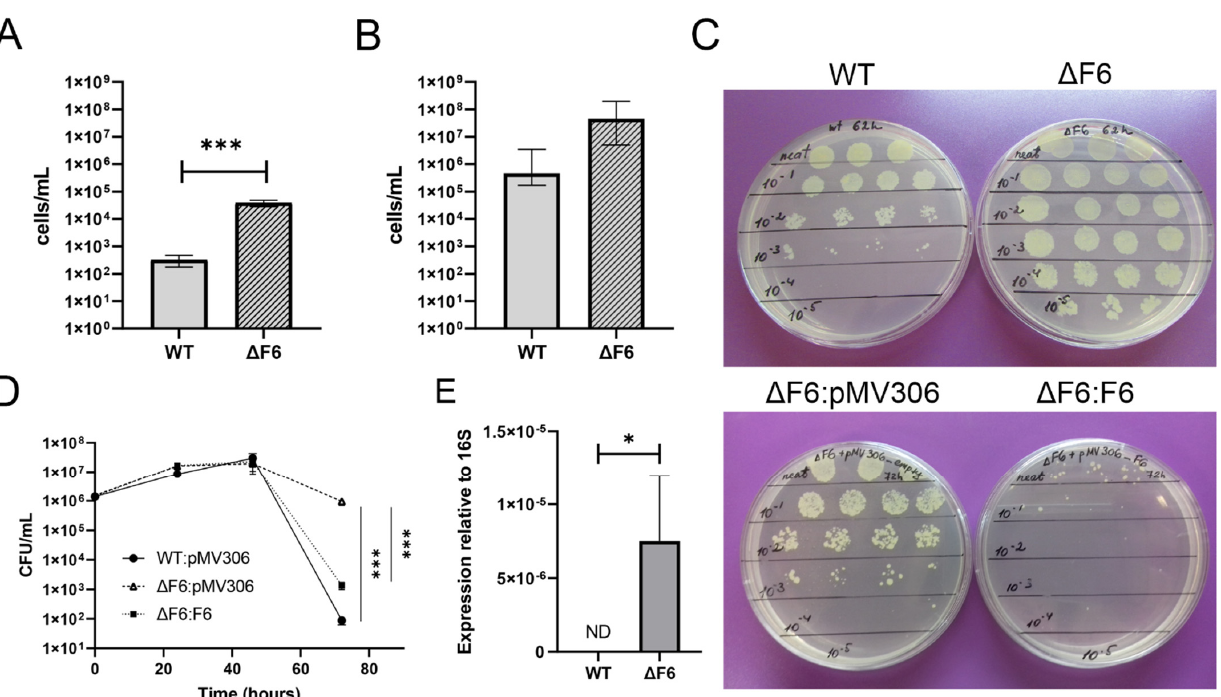
Figure 5. F6 regulates the transition of M. smegmatis to dormancy under growth-limiting conditions. ( A ) Colony-forming unit (CFU) concentration for M. smegmatis wt and Δ F6 strains growing in potassium-limiting conditions at the point of minimal culturability (65 h). ( B ) Reactivation of dormant ‘non-culturable’ M. smegmatis cells in the wt and Δ F6 strains co-cultured with M. luteus at the point of minimal culturability (65 h) in standard Sauton’s medium (most probable numbers, MPN). ( C ) Culturability of M. smegmatis wt and Δ F6 strains under potassium-limiting conditions. ( D ) Growth of M. smegmatis wt, Δ F6:pMV306, and Δ F6:F6 strains in potassium-deficient medium. ( E ) qRT-PCR analysis of MSMEG_4640 expression in wt and Δ F6 cultures growing under potassium limiting conditions (45 h). The data are presented as the mean ± SD of four ( A , B , D ) or three ( E ) biological replicates for each strain; * p < 0.05 and *** p < 0.001.